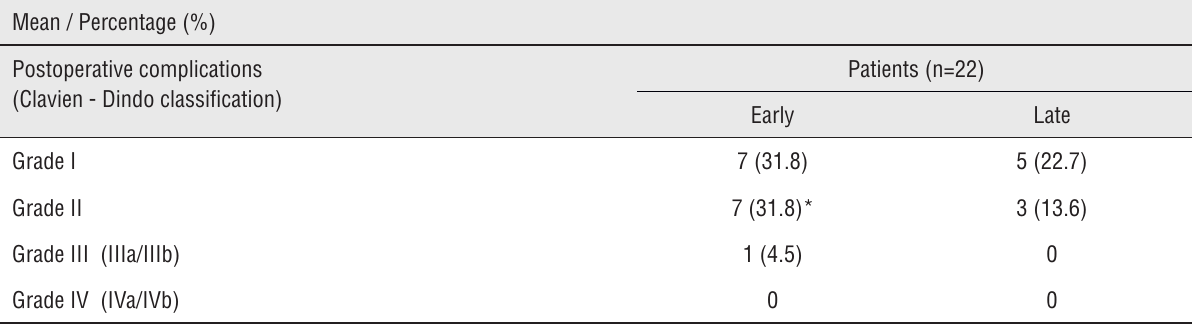
Table 2 - Clavien - Dindo classification of diversion - related complications and its incidence during early ( ≤ 3 months) and late (>3 months) postoperative follow-up period.